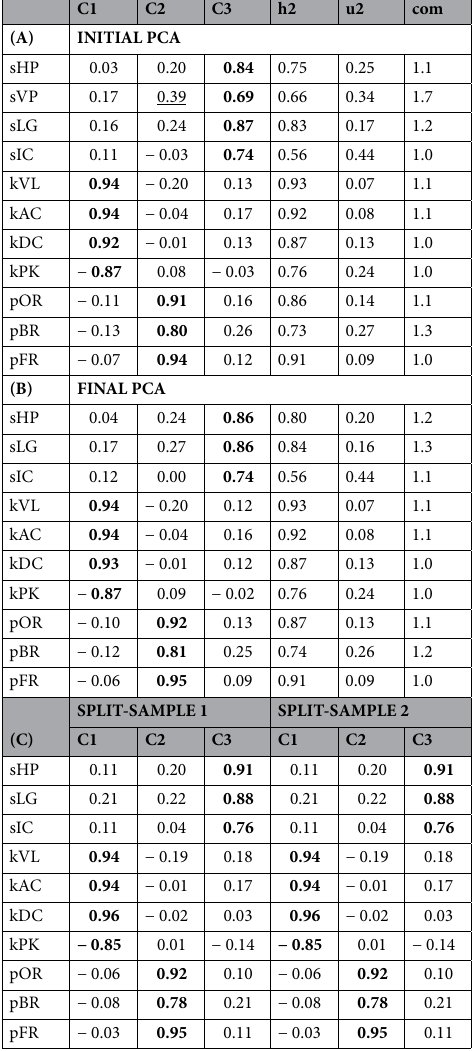
Table 3. Standardised loadings (pattern matrix) based upon correlation matrix for the three components (C1, C2, and C3) solution using orthogonal (i.e., Varimax) rotation of the loading matrix for the initial principal component analysis (PCA) (panel A) and the final PCA (panel B). Primary loadings > ± 0.40 are shown in bold. Secondary loadings > ± 0.30 are underlined. The column "h2" contains the component communalities (i.e., the amount of variance in each index variable explained by the components). The column "u2" contains the component uniquenesses (i.e., the amount of variance not accounted for by the components—or 1–h2). The column "com" reports the Hoffman’s index of complexity for each item (i.e., the number of latent components required to account for the observed variables) 88,89 . Panel C) Validation of component analysis by split sample estimation with Varimax rotation. The two tables report standardised loadings (pattern matrix) based upon correlation matrix for the three components (C1, C2, and C3) solution using Varimax oblique rotations of the loading matrix for the two samples. Primary loadings > ± 0.40 are shown in bold. The column "h2" contains the component communalities (i.e., the amount of variance in each index variable explained by the components). sHP horizontal placement accuracy, sVP vertical placement accuracy, sLG length accuracy, sIC inclination accuracy, pBR base rectangle priority, pOR organisation by relevance, pFR fragmentation, kVL mean velocity, kAC mean acceleration, kDC mean deceleration, kPK number of peak